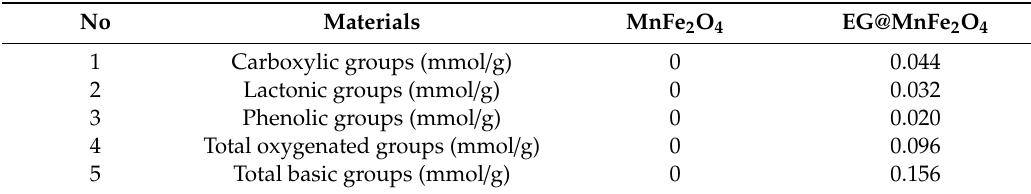
Table 3. Surface groups obtained from Boehm titrations and textual properties of MnFe 2 O 4 and